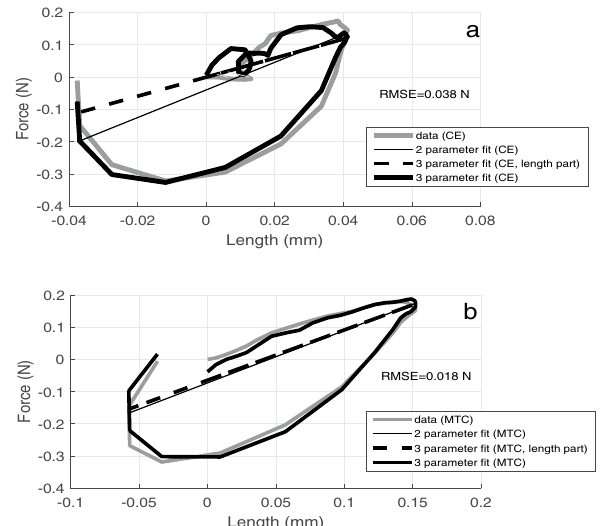
Figure 3. The work-loops of CE ( a ) and MTC ( b ) in one passive exemplary trial. The solid, dark-grey loops are the L CE ,0 or L MTC ,0 responses, respectively, to (cid:31) F . The solid, thin, black line is the respective linear 2-parameter (force (length)) fit to the data. The solid, black loops depict the respective 3-parameter fits to the data, using the parameters k i , b i , d i of each the function F i ( L i , ˙ L i ) (see Eq. 1), which linearly depends on length L i and time rate of length change ˙ L i ; the dashed, black line is the respective length-dependent contribution. Both work-loops encompass one oscillation period that spans between TD and the instant when a COM returns closest to zero for the second time (Supplementary Fig. S1). The Root Mean Square Error (RMSE) for the 3-parameter fit to data in ( a , b ) is 0.038 N and 0.018 N, respectively.